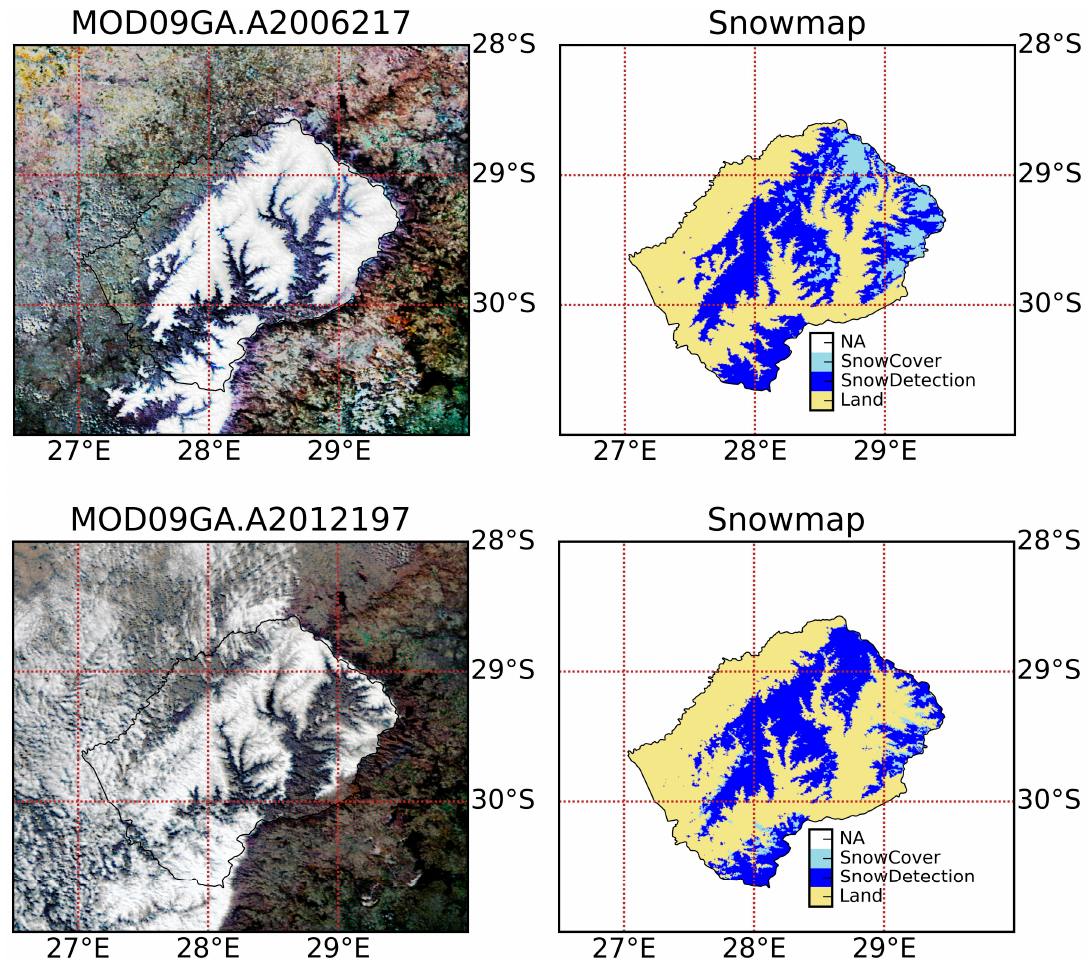
Figure 2. MODIS images (R: Band1; G: Band4; B: Band3) from 5 August 2006 ( upper row ) and from 15 August 2012 ( lower row ) with retrieved snow maps ( right ). Retrieval based on MODIS MOD09GA data (dark blue = “Snow Detection”); gap filling with temporal-spatial post-processing (light blue = “Snow Cover”).